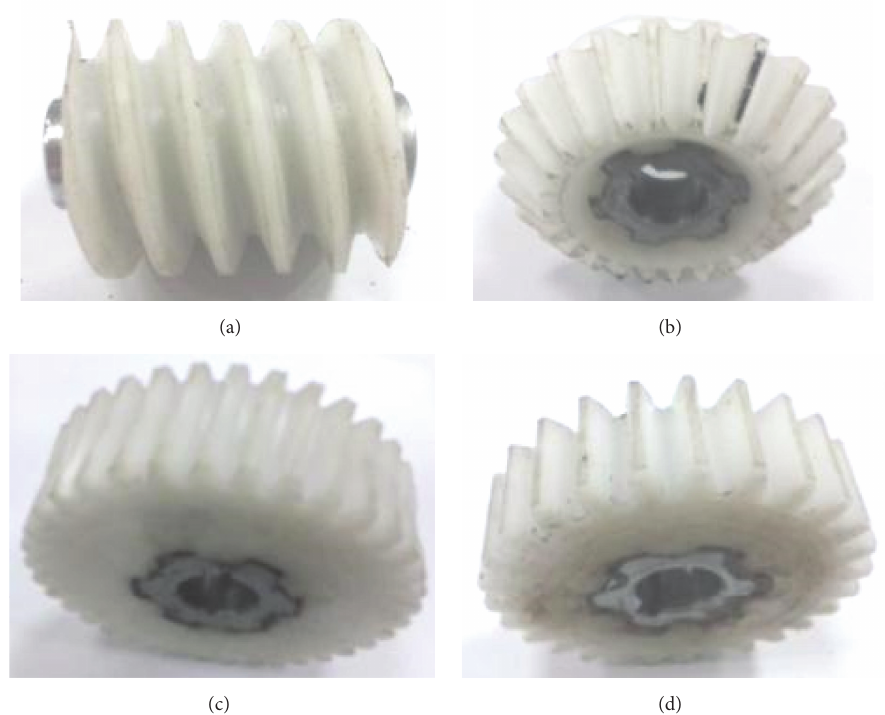
Figure 2: Tested polymer gears: (a) worm gear, (b) bevel gear, (c) wheel gear, and (d) spur gear.